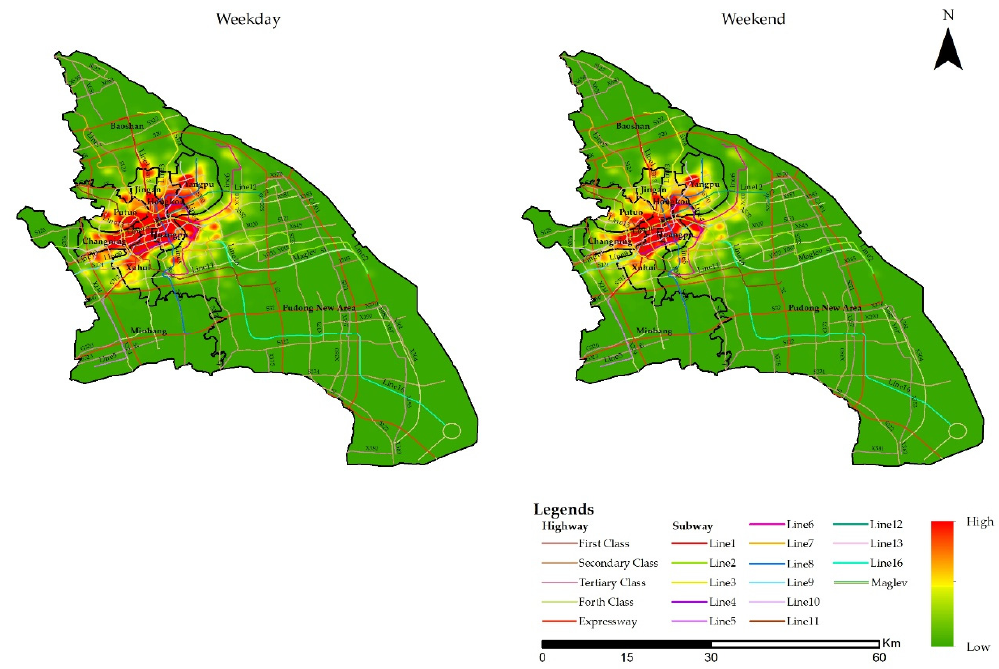
Figure 5. Check-in density during weekdays and the weekend. Figure 5. Check ‐ in density during weekdays and the weekend.